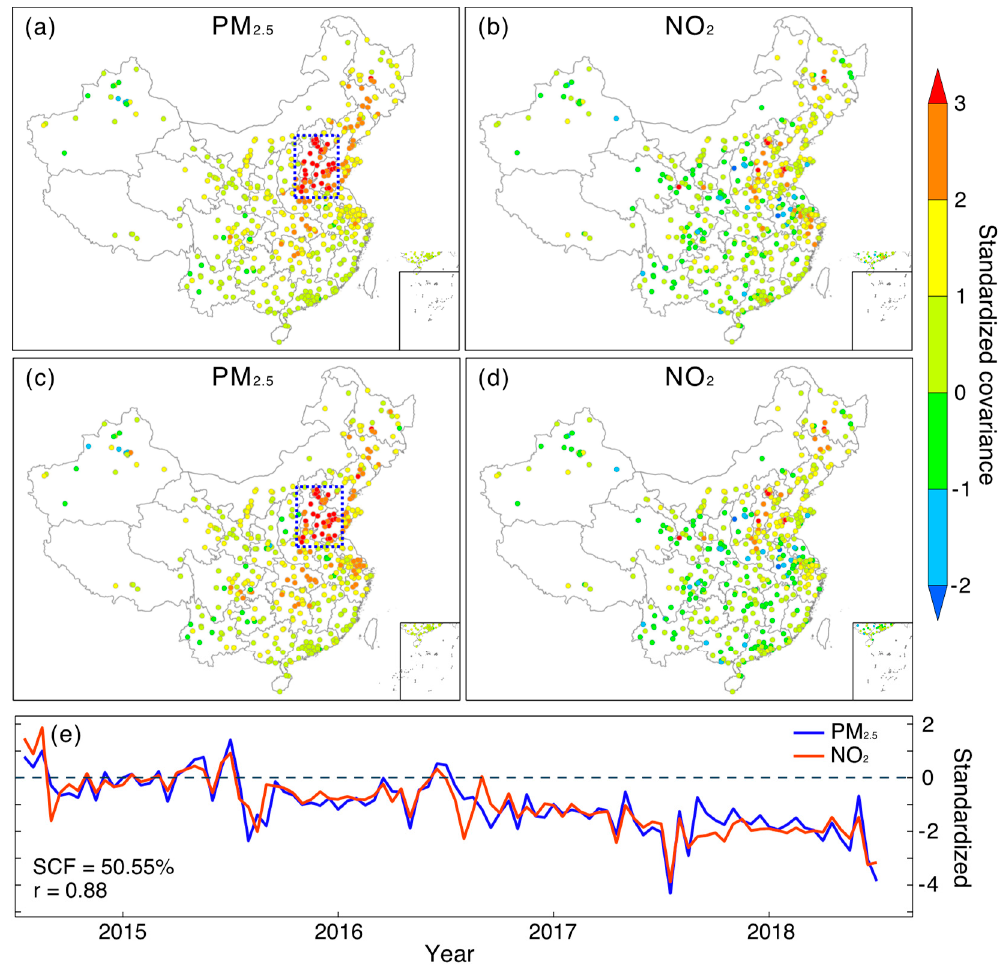
Figure 5. Same as Figure 4, but for coupled fields between PM 2.5 and NO 2 . ( a–b ) Homogeneous covariance maps (covariance between expansion coefficient and time series of the same original field); ( c–d ) heterogeneous covariance maps (covariance between expansion coefficient and time series of another field); ( e ) standardized expansion coefficient (divided by their standard deviations) of the first MCA mode.